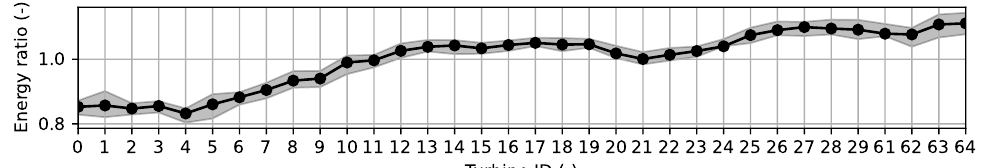
Figure 6. The energy ratios for all upstream wind turbines at the Anholt wind farm normalized to the average of all turbines for a wind sector of 262.5 ◦ to 277.5 ◦ , equal to wind coming from the west. For this wind direction, turbines very south in the farm (e.g., T0, T1) generate 15% less energy than the average of all upstream turbines, whereas turbines far north in the farm (e.g., T63, T64) generate 10% more. The shaded region represents 90% confidence intervals.